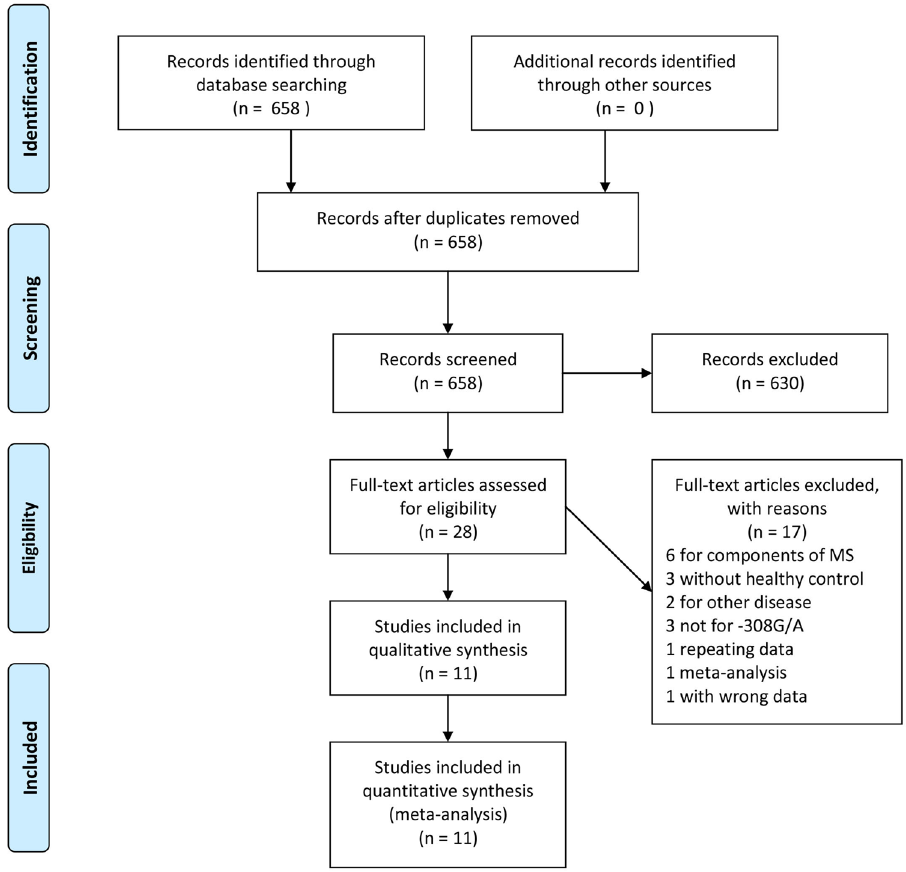
Figure 1. Flow chart of research and selection process.